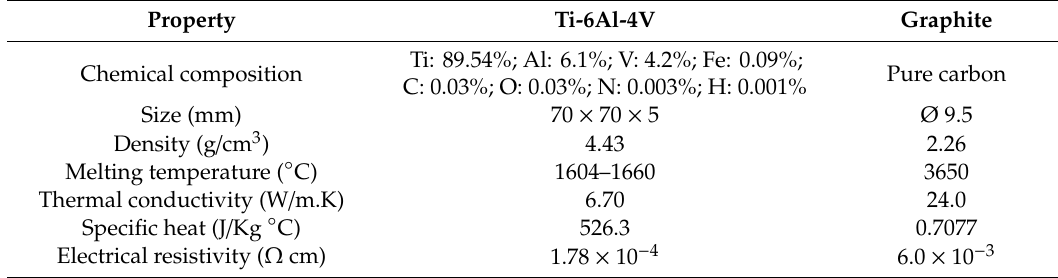
Table 1. Physical properties of workpiece and electrode materials. Source: www.matweb.com.